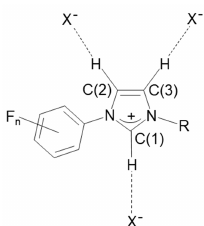
Figure 1. Hydrogen bond donor sites of the 1,3-disubstituted imidazolium cation showing the labeling scheme.